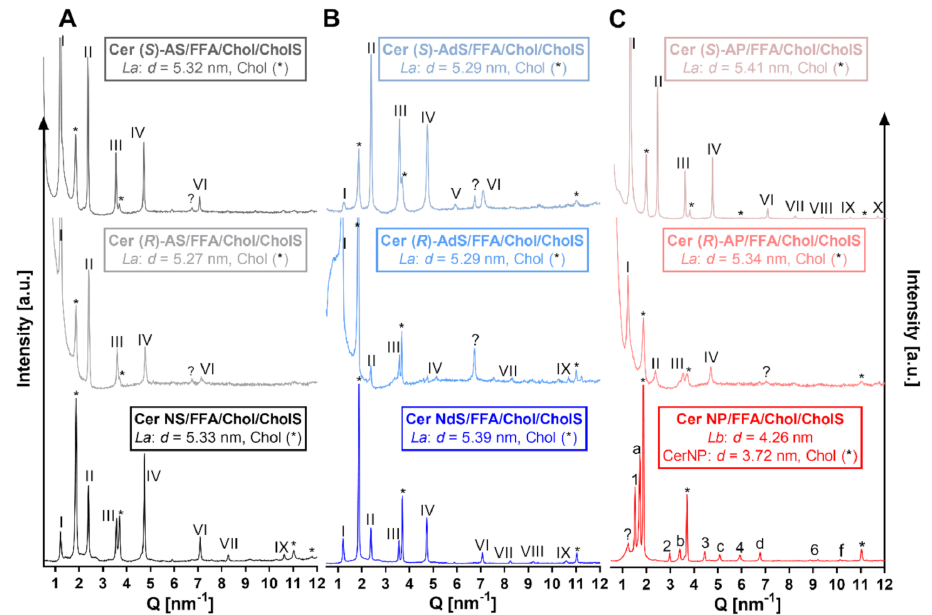
Figure 2. XRD diffractograms of Cer/FFAs/Chol/CholS membranes containing either sphingosine (Cer NS, Cer ( R )–AS, or Cer ( S )–AS; Panel ( A ) or dihydrosphingosine (Cer NdS, Cer ( R )–AdS, or Cer ( S )–AdS; Panel ( B ) or phytosphingosine Cers (Cer NP, Cer ( R )-AP, or Cer ( S )–AP; Panel ( C ) at ambient room humidity. Intensity is given in arbitrary units (a.u.). Roman numerals mark the La phase ( d = 5.3–5.6 nm); Arabic numerals mark the Lb phase ( d = 4.3 nm); letters belong to the phase of crystalline Cer NP ( d = 3.7 nm); asterisks mark separated Chol ( d = 3.4